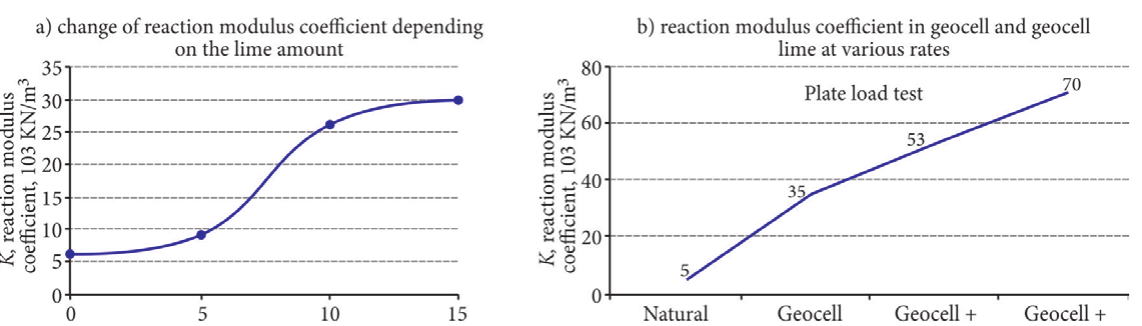
Figure 8. Reaction modulus coefficient values in case of using lime at various rates and